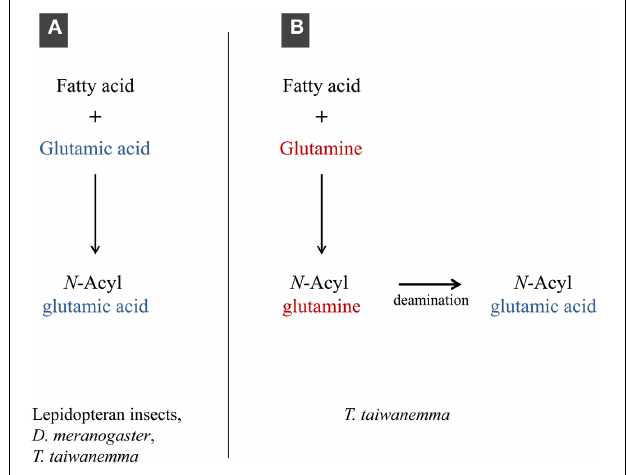
FIGURE 5 | Two biosynthetic pathways of glutamic acid conjugates. (A), direct conjugation observed in lepidopteran insects, D. melanogaster and Teleogryllus crickets; (B) , deamination in Teleogryllus